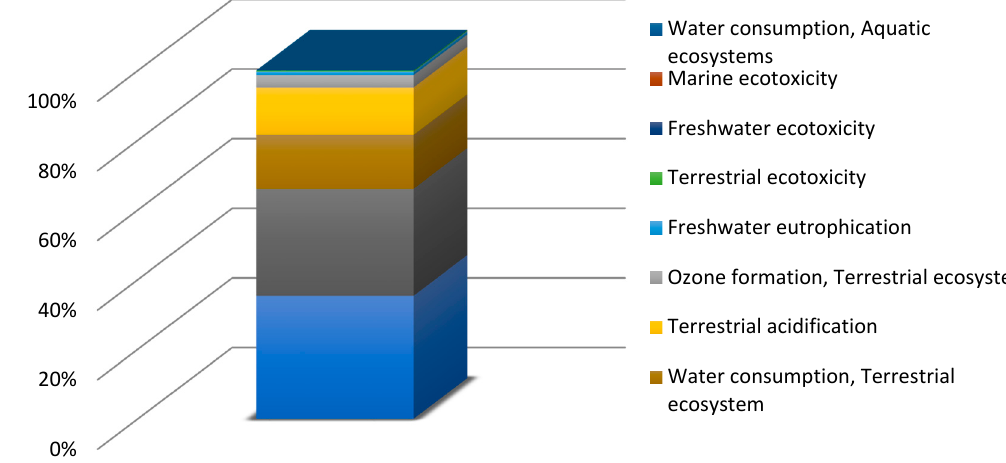
Figure 5. Contribution analysis in the ecosystem quality damage category.